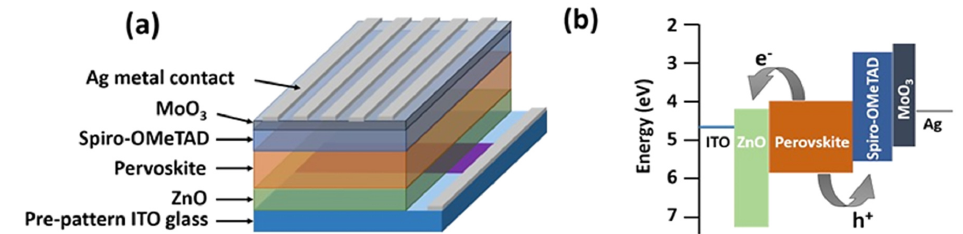
Figure 1. ( a ) The construction of the perovskite solar cell (PSC), and ( b ) the energy level diagram of materials used in the perovskite photovoltaic device in this study. materials used in the perovskite photovoltaic device in this